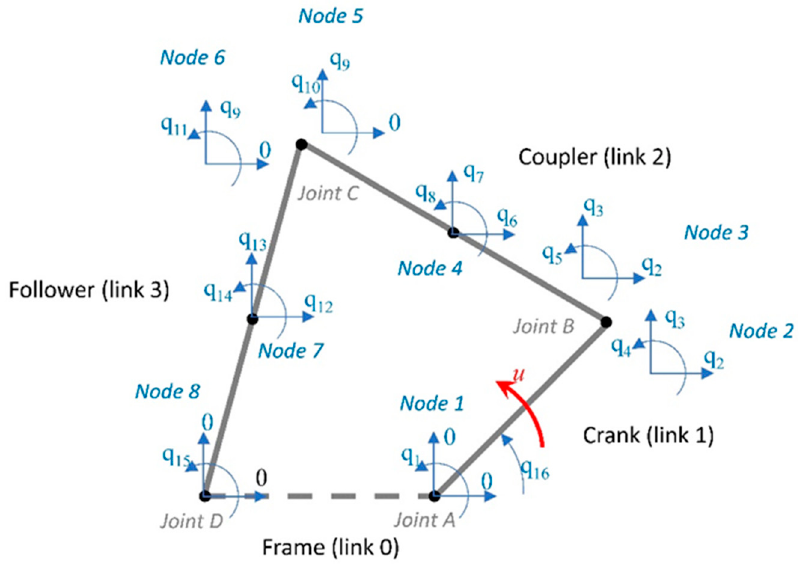
Figure 10. Four-bar linkage: system model (test-case 4) (reproduced from [16]). Table 8. Four-bar flexible-link mechanism parameters ([16]).